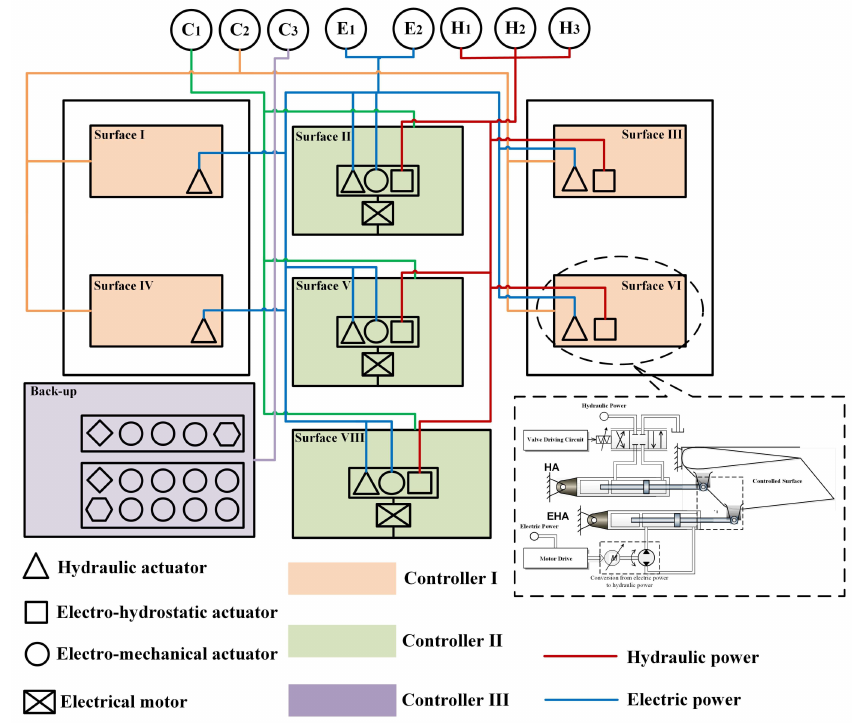
Figure 10. A typical 3H2E more electric control system